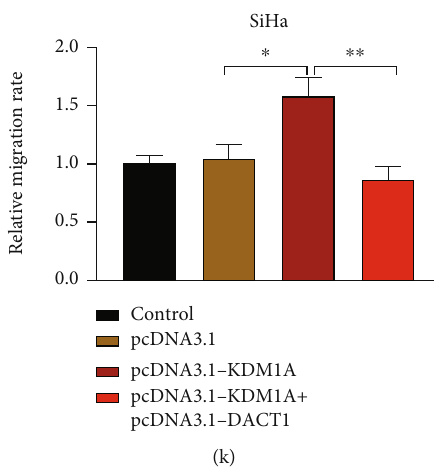
Figure 5: Overexpression of DACT1 reverses the promotive e ff ect of KDM1A overexpression on cervical cancer cells. (a) mRNA expression levels of KDM1A and DACT1in HeLa cells by qRT-PCR; (b) protein expression levels of KDM1A and DACT1in HeLa cells by western blot; (c) mRNA expression levels of KDM1A and DACT1in SiHa cells by qRT-PCR; (d) protein expression levels of KDM1A and DACT1in SiHa cells by western blot; (e) CCK8 assay to measure the cell proliferation ability in HeLa cells; (f) CCK8 assay to measure the cell proliferation ability in SiHa cells; (g) cell clone formation for cell clone count in both HeLa and SiHa cells; (h, i) wound healing assay to measure the migration ability of HeLa cells; (j, k) wound healing assay to measure the migration ability of SiHa cells; ∗ p < 0 : 05 and ∗∗ p < 0 : 01 . ns: not signi fi